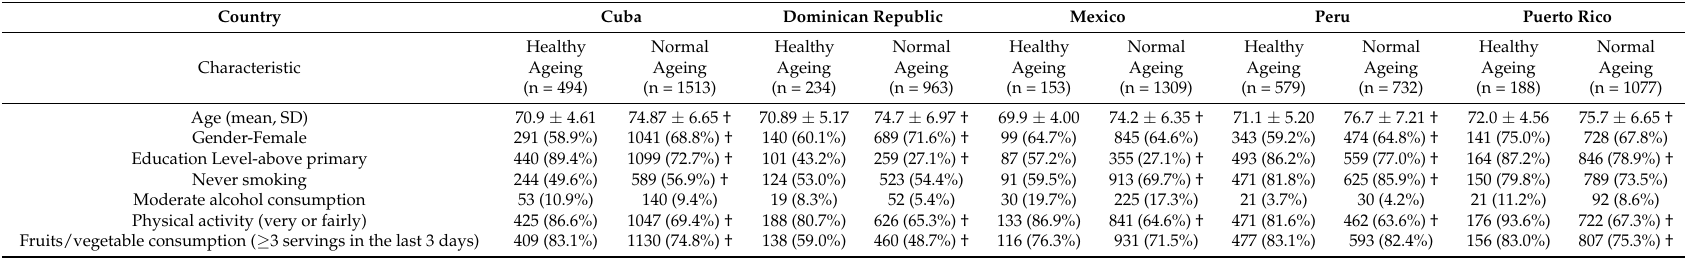
Table 1. Baseline characteristics of participants in the healthy and normal ageing group * in the follow-up wave. Country Cuba Dominican Republic Mexico Peru Puerto Rico Healthy Normal Characteristic Ageing Ageing (n = 494)